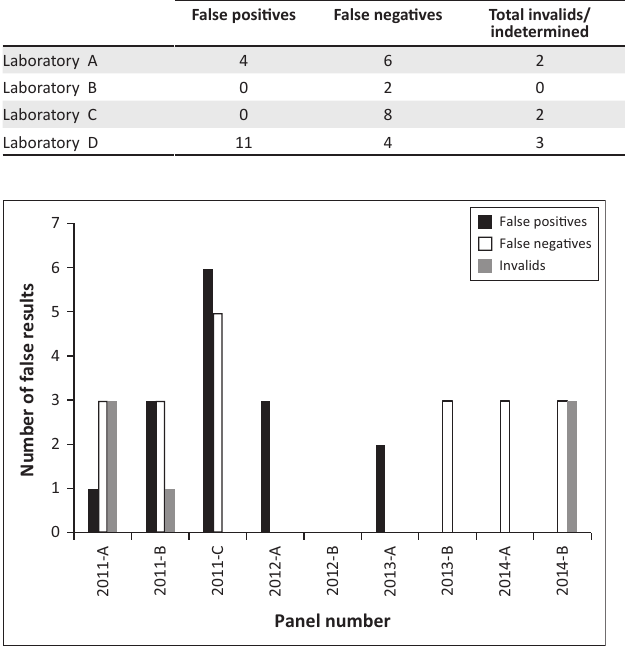
FIGURE 1: Percentage of discordant results among all participating technicians. Discordant results included false positives, false negatives and invalids.